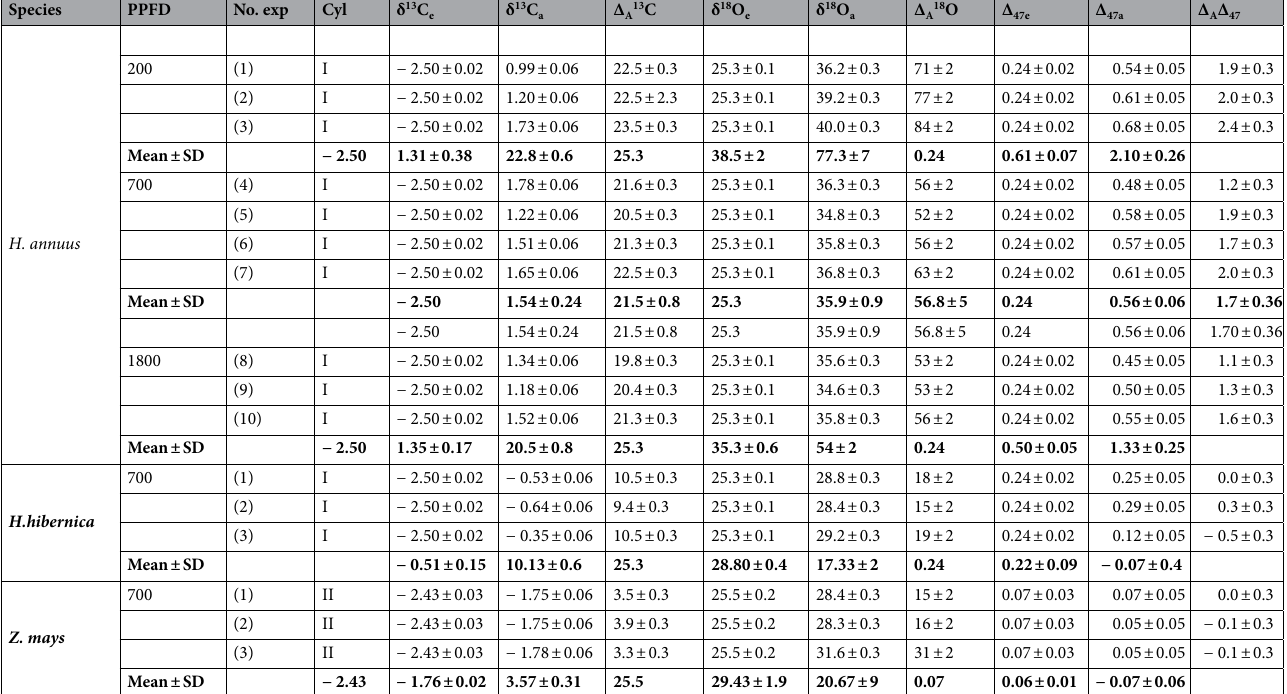
Table 2. Isotopic composition of the CO 2 entering and leaving the leaf cuvette and the resulting isotopic discrimination against the isotopologues 13 C 16 O 16 O, 12 C 18 O 16 O and 13 C 18 O 16 O given as Δ A 13 C, Δ A 18 O and Δ A Δ 47 . All the isotope and discrimination values are reported in per mill (‰), with respect to VPDB (for δ 13 C) and VSMOW (for δ 18 O). The values in bold are mean and standard deviation for the replicates at different light